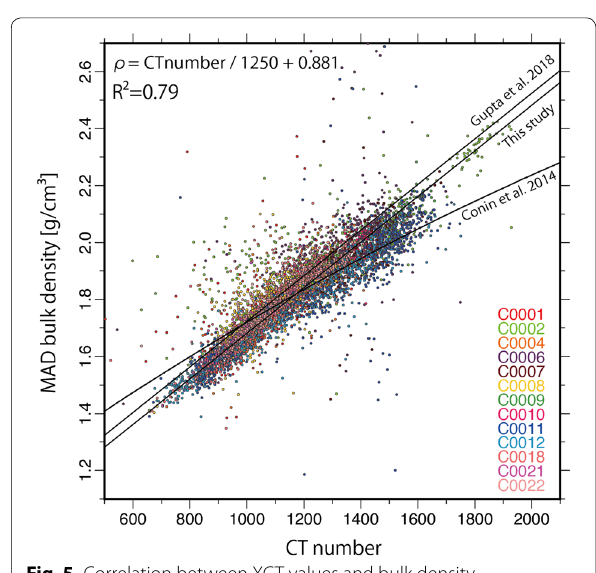
Fig. 5 Correlation between XCT values and bulk